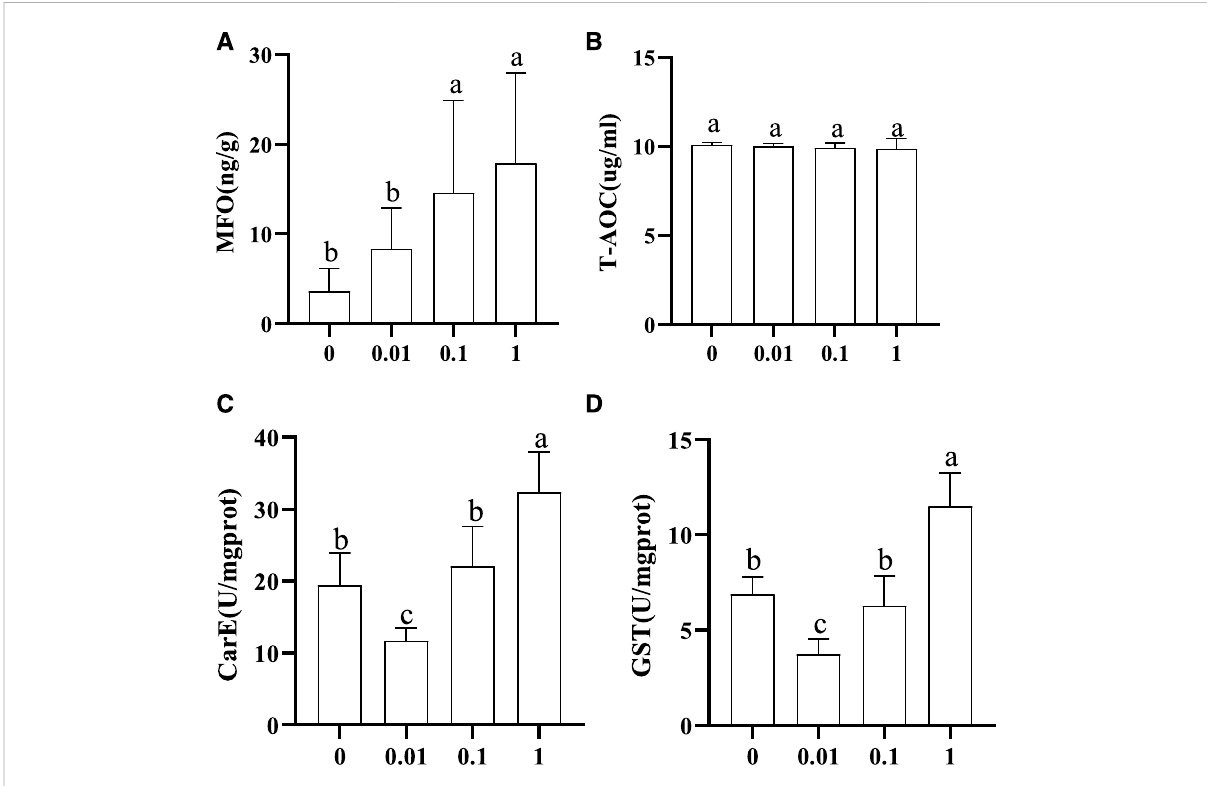
FIGURE 2 Effect of fl umethrin on the content of immune and detoxi fi cation-related enzymes in honeybee larvae. The same letter above the bars means no signi fi cant difference. (A – D) represent the content of MFO, T-AOC, CarE, and Gst measured in each group, respectively.